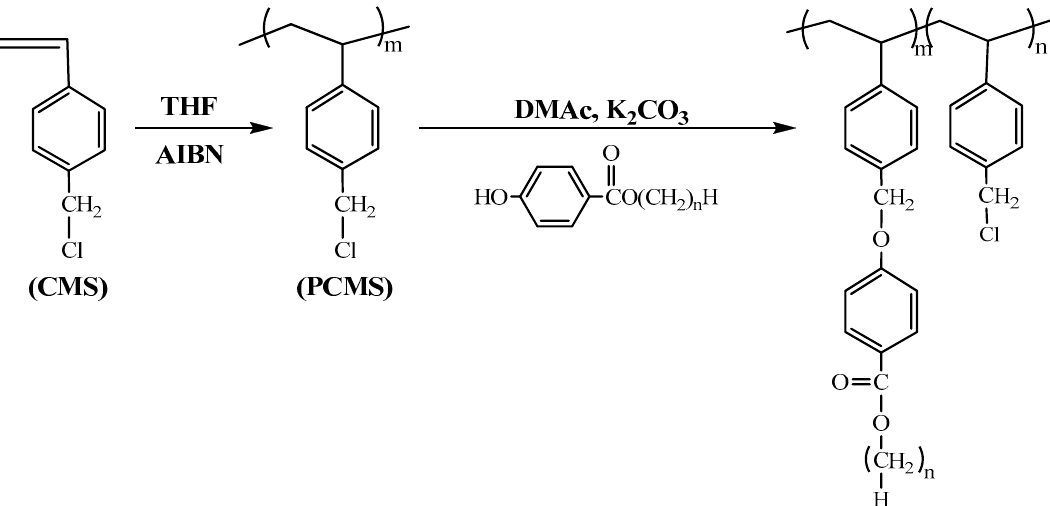
Figure 1. Synthetic route to butyl hydroxybenzoate (PBHB#, n = 4) and methyl hydroxybenzoate (PMHB100, n = 1) and ethyl hydroxybenzoate-substituted polystyrene (PEHB100, n = 2), where # represent the molar fraction of butyl hydroxybenzoate containing monomeric units in the polymer.